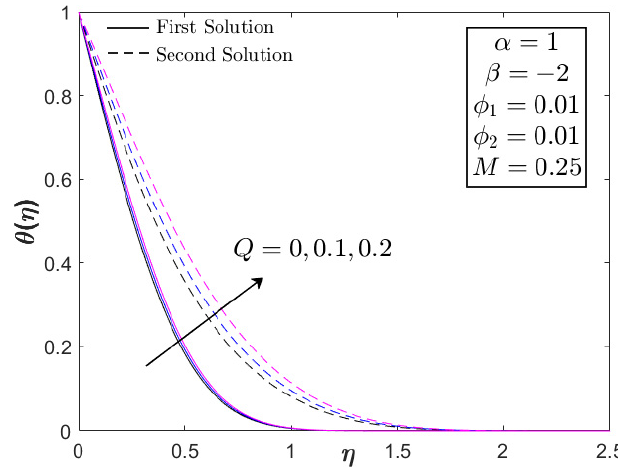
Figure 11. Temperature profile of Fe 3 O 4 –CoFe 2 O 4 /H 2 O with different M .